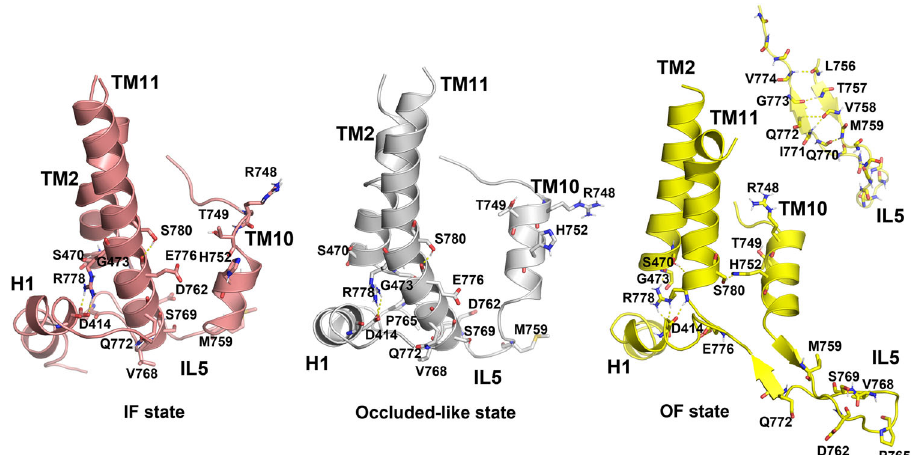
Fig. 6 Reorganization of TM11 and IL5 during IF to OF transition in AE1. Representative structures from MD simulations demonstrating changes in the area of TM10, IL5, and TM11 during the transition from IF to OF state: IF structure, showing the elongated TM11 (left, salmon helices); occluded-like state obtained during MD simulation after TM10 moves within the IF cavity (see Supplementary Videos 4,5) and TM11 bends at R778 (center, white helices); OF state demonstrating β -hairpin organization of IL5 (right, yellow helices and β -hairpin). The backbone atoms of IL5 forming the β -sheet are also shown as an inset. The H-bond networks between relevant residues are shown with dashes. Relevant residues studied with functional mutagenesis in this work or implicated in pathological states, are shown as